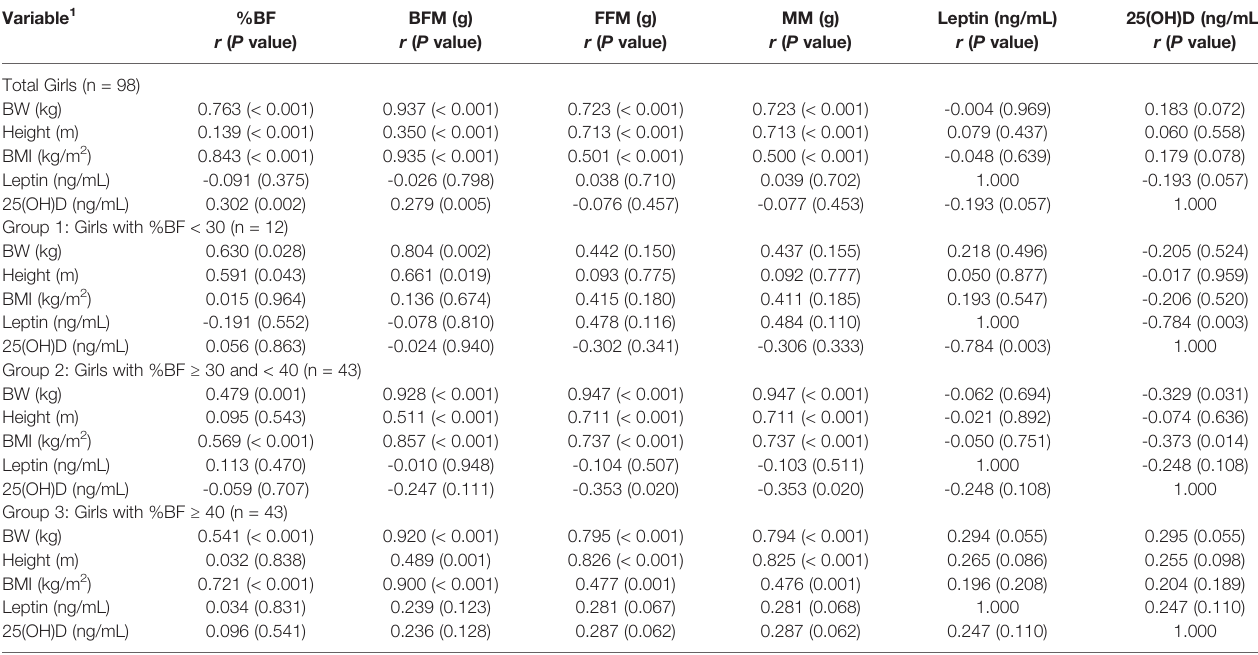
TABLE 4 | Correlation coef fi cient, r ( P value), between BMI parameters, body composition, leptin, and 25(OH)D in girls. Variable